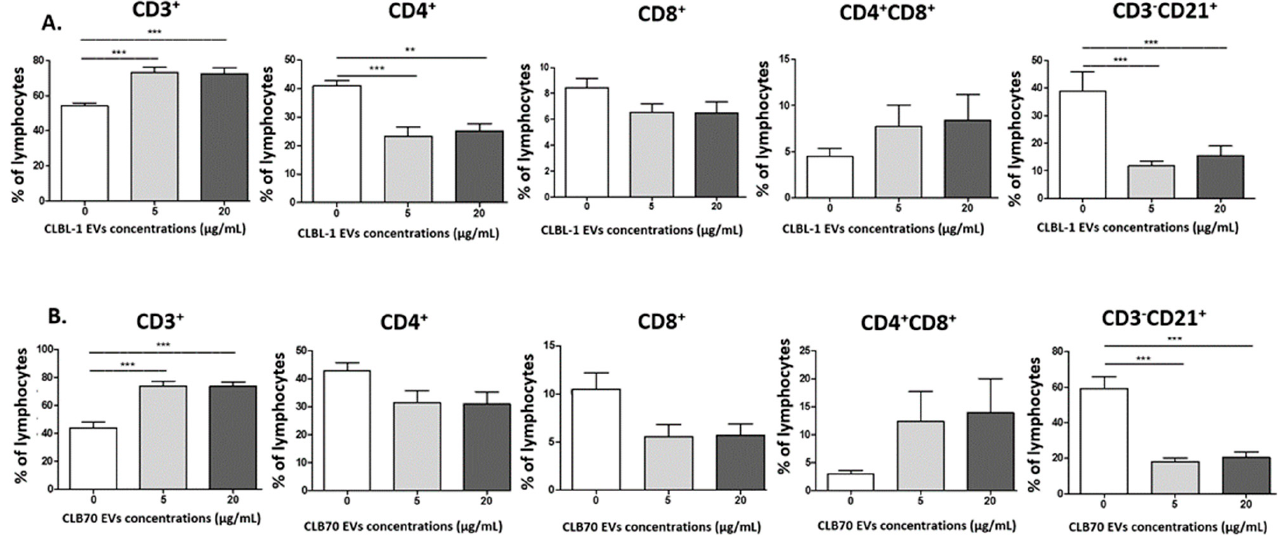
Figure 3. Influence of TEVs on the percentage of subpopulations of activated lymphocytes. The percentage of CD3 + , CD4 + , CD8 + , CD4 + CD8 + , and CD3 − CD21 + lymphocytes after 5 days of culture of PBMC in a 37 °C, 5% CO 2 environment with ConA and IL-2 in the presence of CLBL-1 EVs ( A ) and CLB70 EVs ( B ) in two concentrations or without TEVs (n = 7). The results are presented as the mean ± SEM. The significance levels are: ** p < 0.01 and *** p < 0.001.